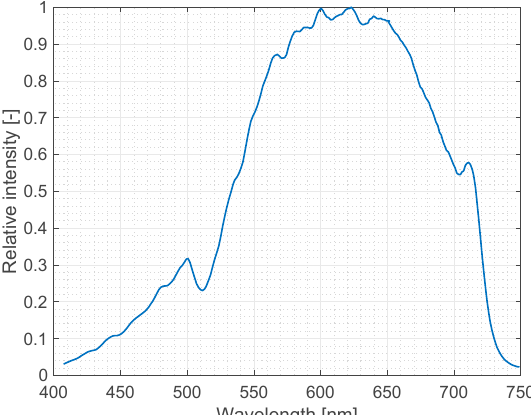
Figure A1. Relative intensity of the monochromator light source as detected by the camera. The intensity was normalized to the maximum value to aid with visualization. Please note that the intensity recorded by the camera is a product of the halogen light source spectrum, transmittances of all the optical components in the light path, and sensitivity of the detector.